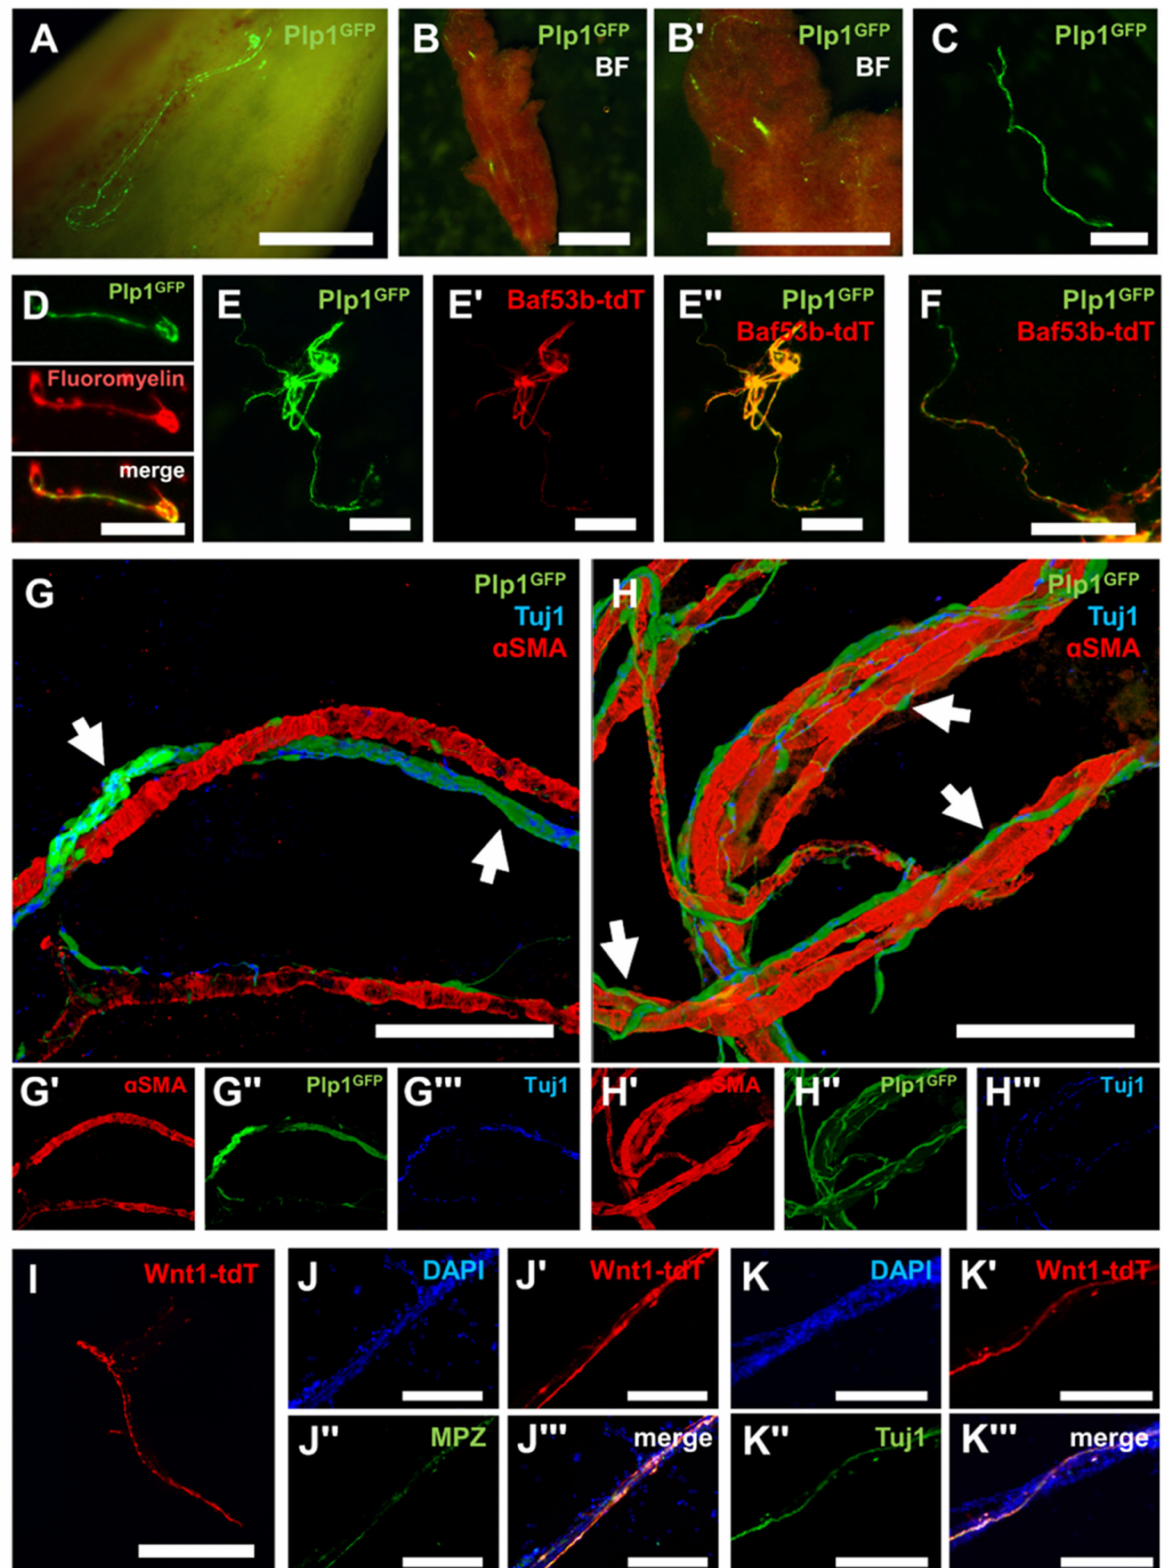
Figure 1. Neural crest-derived Schwann cells reside in the perivascular space of bone marrow in association with nerve fibers. ( A ) Representative high magnification image of the endosteum of